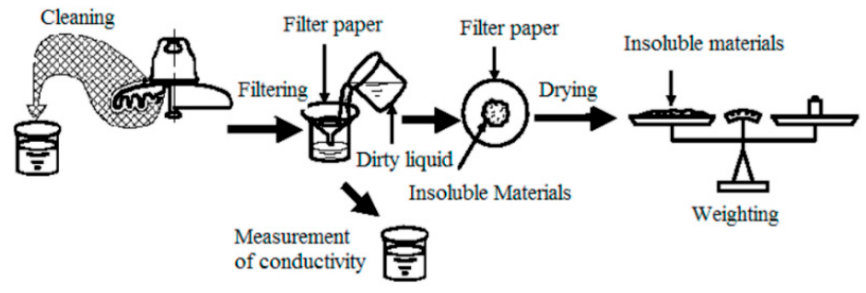
Figure 3. The flowchart of the measuring of the ESDD and NSDD.